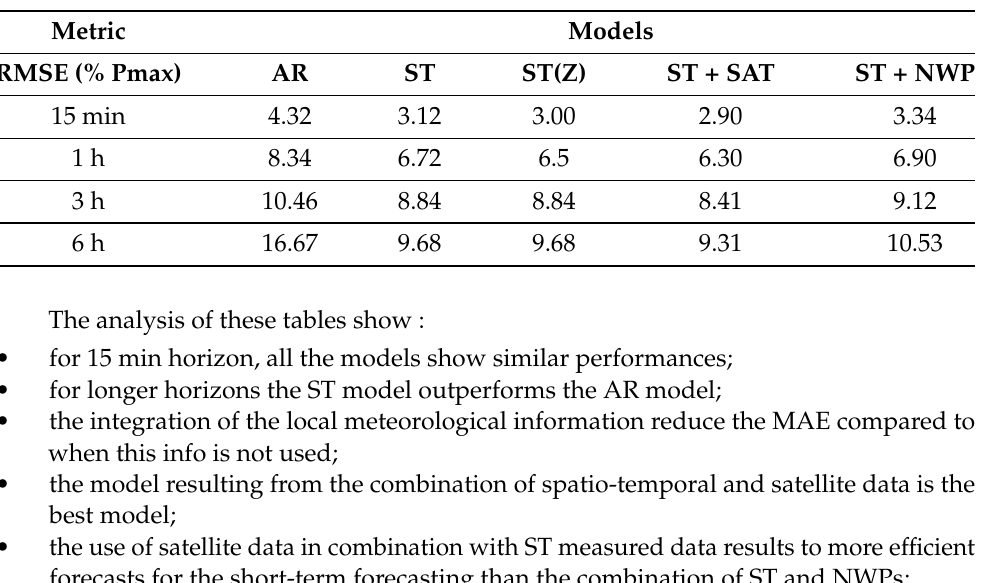
Table 3. RMSE of the models for a power plant of